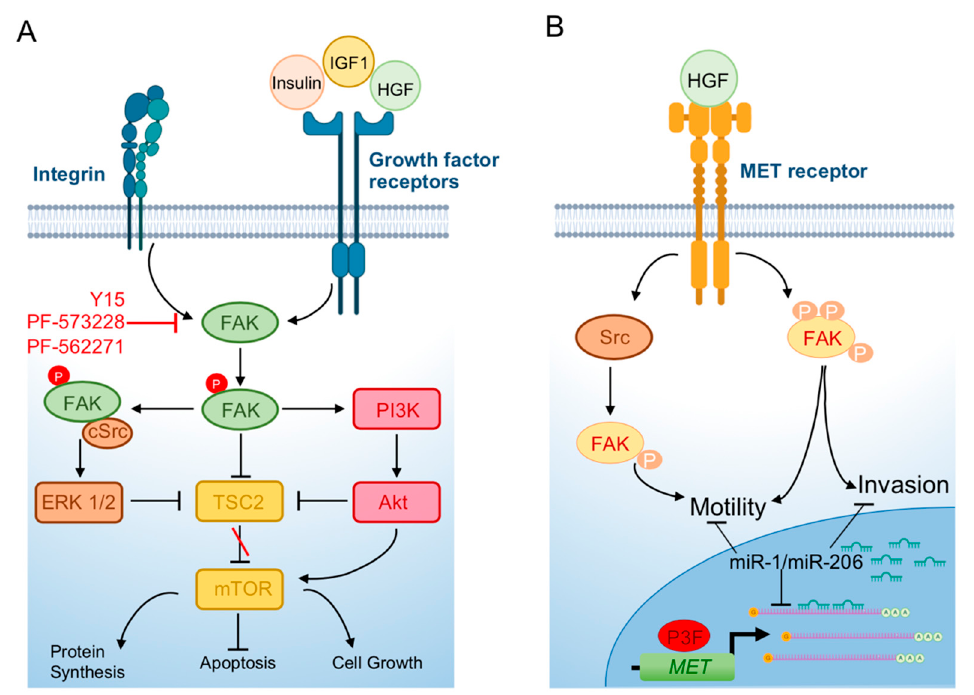
Figure 4. FAK involvement in rhabdomyosarcoma. ( A ) FAK is phosphorylated and activated upon binding of growth factors to the RTK receptors and integrins activation. Phosphorylated FAK promotes cell growth and protein synthesis and blocks apoptosis through activation of PI3K-AKT-mTOR signaling. The FAK–Src complex (i) induces the ERK1 / 2 pathway, leading to the reduction of phosphorylated TSC2 which results in increased mTOR activity; and (ii) blocks TSC2 directly. ( B ) In rhabdomyosarcoma, MET, which is a transcriptional target of PAX3-FOXO1 (P3F), is overexpressed and induces signal cascades, promoting motility and invasion also through FAK activation. In these tumor cells, the “MyomiRs” miR-1 / miR-206 are downregulated and when forcedly expressed, they target MET mRNA and block its translation, resulting in a block of invasion and motility. Figure realized with BioRender.com.